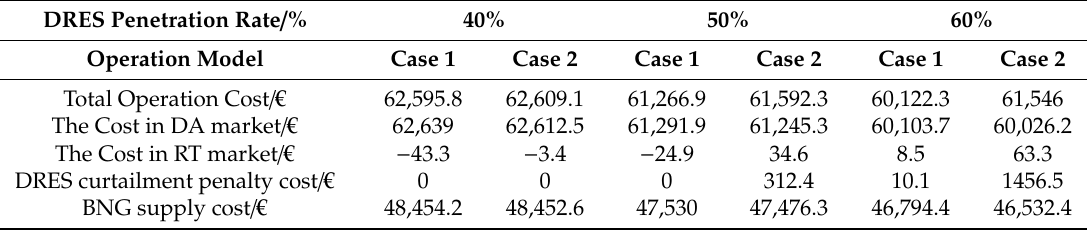
Table 1. The IES operation cost under di ff erent DRES penetration